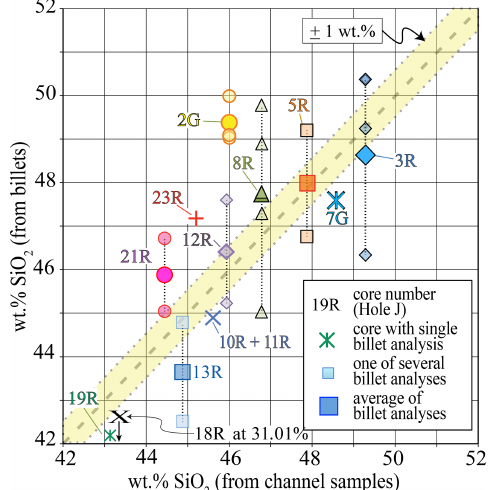
Figure 10. The comparison of bulk MgO concentrations of channel samples from core from Hole J with the analyses of billets analyzed aboard the JR from the same cores. The concentrations of MgO in single billets and from averages of billets from 9 out of 11 cores differ by more than 0.5wt% (yellow band) from the compositions of the channel samples of the same cores, showing that analyses of billets do not yield representative compositions of the whole core.